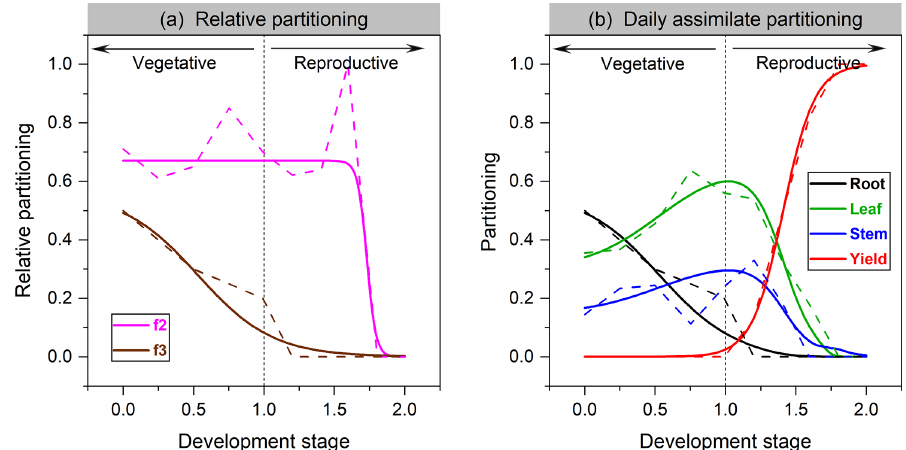
Figure 1. The organ’s relative allocation (a) and assimilate partitioning (b) to roots, leaves, stem, and yields for soybean. Solid lines represent the fitted Richards functions in this study, and dashed lines are the allocation scheme from Penning de Vries et al. (1989). f 2 in (a) denotes leaf relative allocation to shoot vegetative organs (Eq. 4), whereas f 3 is root relative allocation to vegetative organs (Eq.